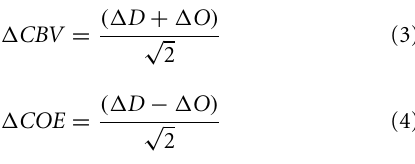
detectors indicate channel positions. Curved lines show schematic boundaries of the Brodmann areas. Numbers indicate the Brodmann areas as confirmed by MRI. In this study, only the middle column was taken as the median (Ch 3, 14, 25, 30, 33, 36, 40, and 47).